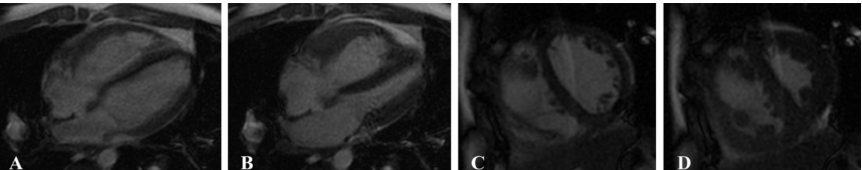
Figure 1. Multiphase cine imaging was performed using a standard steady-state free precession (SSFP) pulse sequence in a 14-year-old male patient with pulmonary arterial hypertension (PAH). Four-chamber long-axis view at the end of diastole ( A ) and end of systole ( B ) and biventricular short-axis views at the end of the diastole ( C ) and the end of the systole ( D ).